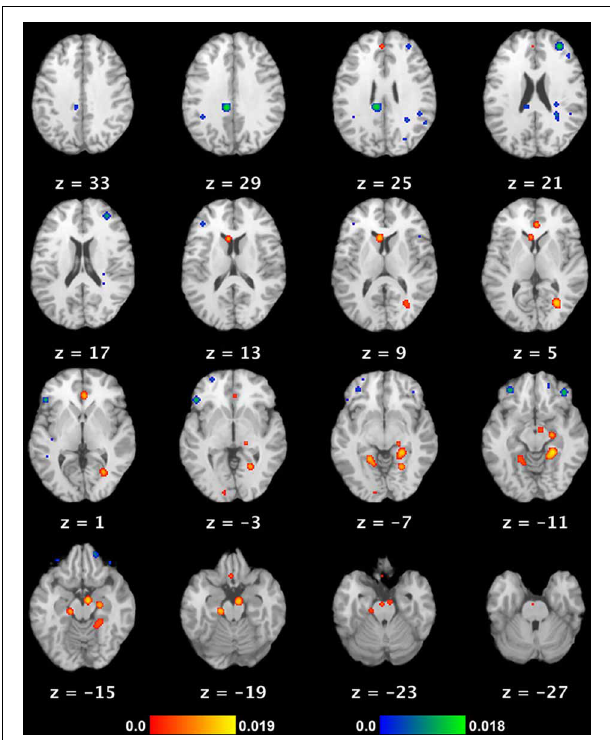
FIGURE 1 | Neural substrate of REM sleep vs. waking rest. Significant meta-analytic clusters contributing to the neural substrate of REM sleep (as a proxy for dream mentation). Axial slices are displayed in Talairach space, with 3mm skip. Color bars indicate likelihood that peaks represent actual peaks of difference at a given voxel. Activations (REM > waking rest) are in red-yellow, deactivations (REM < waking rest) in